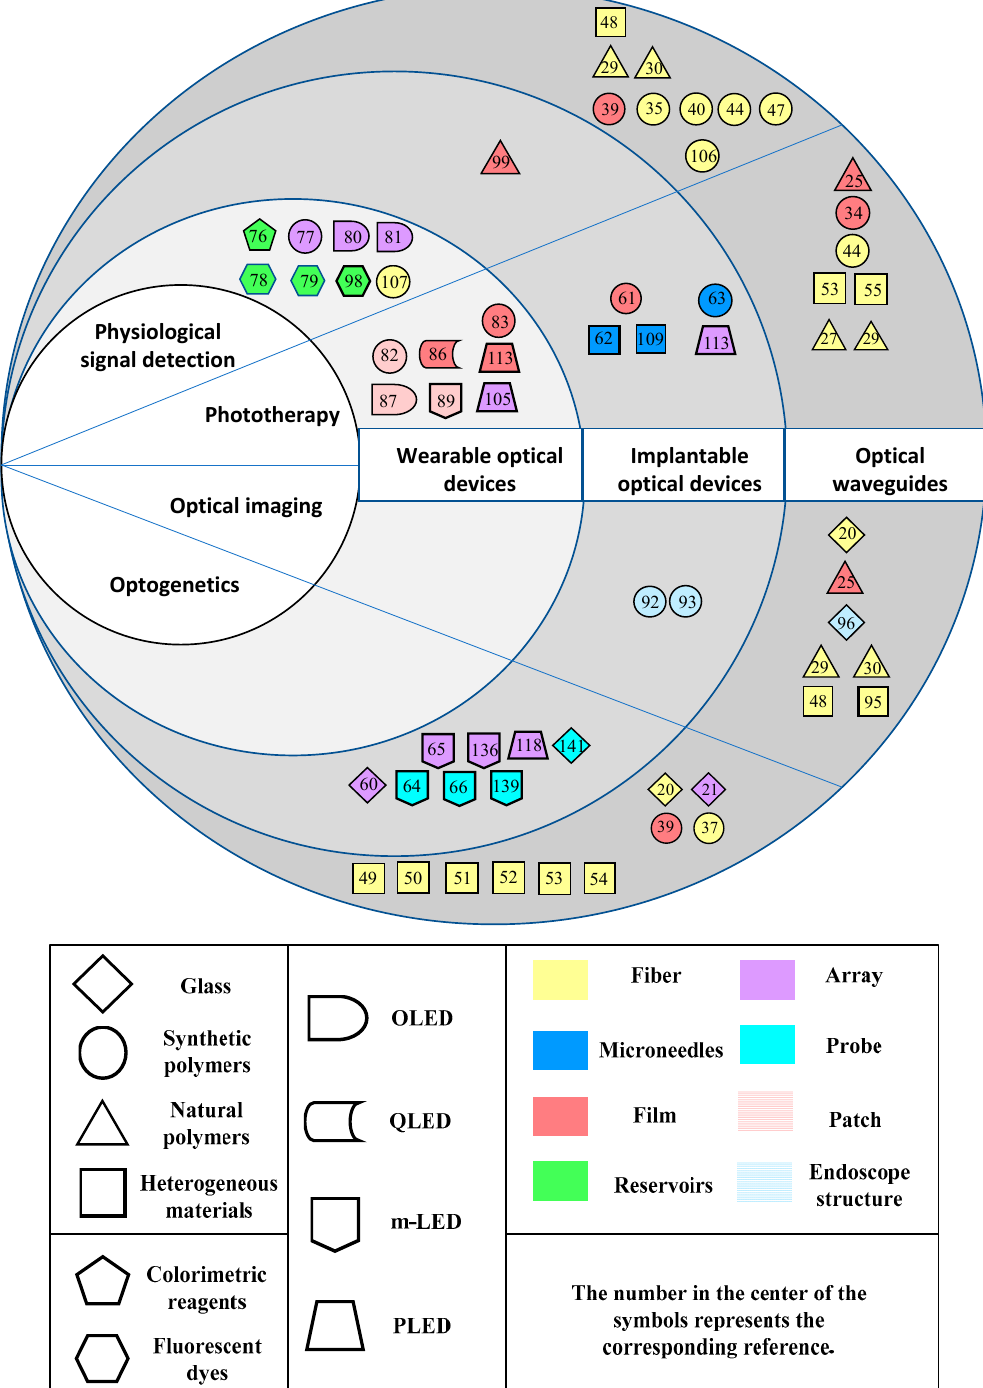
Figure 9. Photomedicine of biocompatible optical devices.